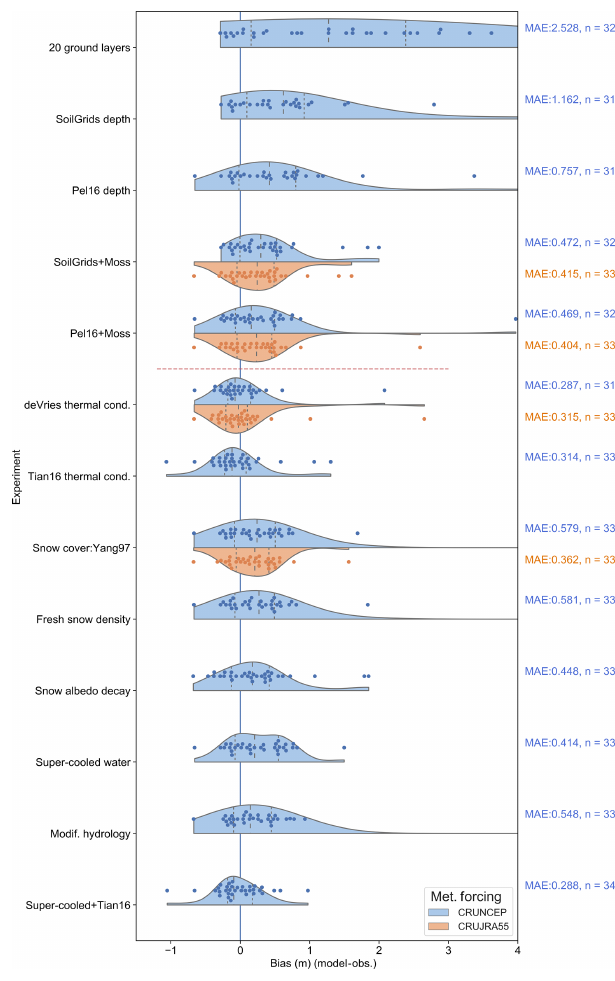
Figure 3. Differences between the ALTs from the experimental model runs and those of the Global Terrestrial Network for Per- mafrost ALT sites (Table S1). Each dot represents a grid cell with one or more GTN-P sites (see Sect. 2.3). In this representation (a “bee swarm”), displacement in the y direction is only to allow each data point to be visible. The background shading is a Gaussian ker- nel density estimate (KDE), with the quartiles of the distribution indicated by dashed vertical lines within the KDE plot. The mean absolute error (MAE) is produced by calculating the MAE at each grid cell and taking the average across all cells. As the number of sites ISPF differs between experiments (Table 2), the number of grid cells where CLASS-CTEM simulated permafrost is also listed. The total number of grid cells with GTN-P sites is 37. The two meteorological forcings are shown for the experiments where the CRUJRA55 forcing was also used. Experiments below the dashed red line use the model setup from Exp. SoilGrids+Moss as their starting point (Table